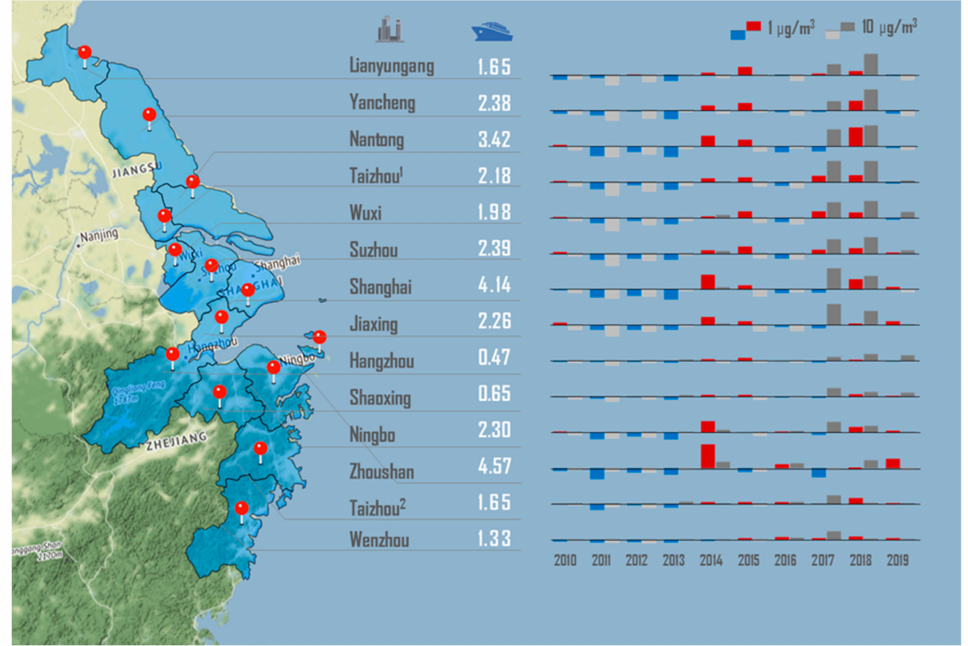
Figure 4. Anomalies of ship-contributed PM 2.5 ( µ g/m 3 ) and all PM 2.5 pollution (ships + other sources) based on the annual average of each year, and the 10-year average of ship-contributed PM 2.5 ( µ g/m 3 ) in 14 coastal cities of